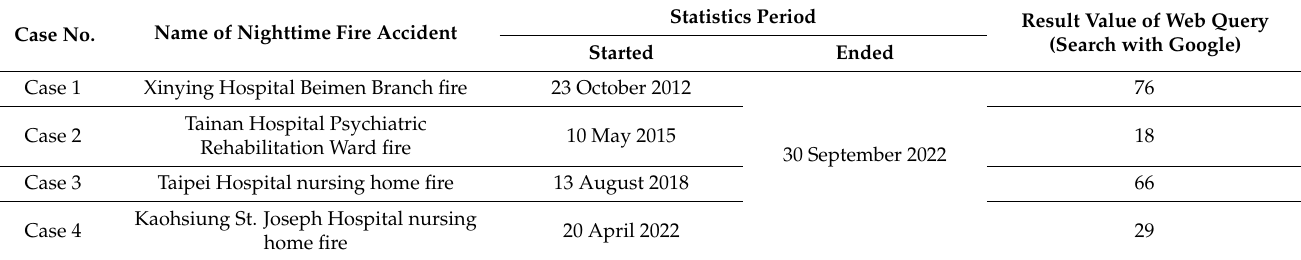
Table 2. The number of websites where the incidents were mentioned.